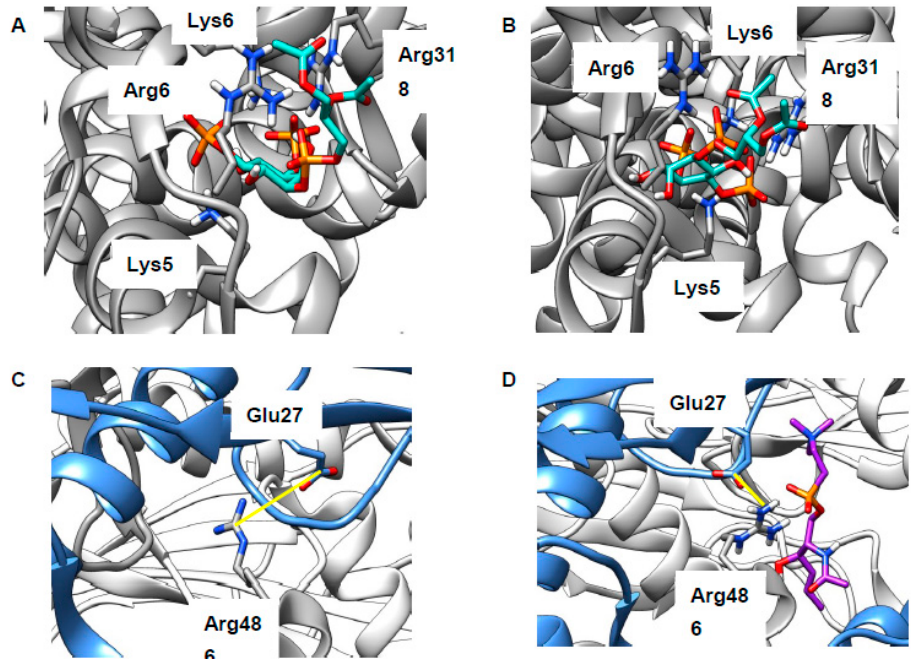
Figure 5. Putative binding sites of lipids at Transient receptor potential mucolipin 1 (TRPML1). ( A , B ) Modeling supports mutagenesis experiments identifying a polybasic region as key the binding site for phosphatidylinositol-3,5-bisphosphate (PI(3,5)P 2 ) (green, A ) and PI(4,5)P 2 (green, B ). ( C ) Glu276 from one chain (blue) forms a charged interaction with Arg486 from another (grey); interatomic distance: 3.77 Å. ( D ) Modeling suggests plausible binding poses for SM (purple, typical example shown), but these do not disturb the inter-residue interactions present in the apo state; interatomic distance: 2.97 Å. Protein oriented as in Figure S3; distance markers are shown in yellow.